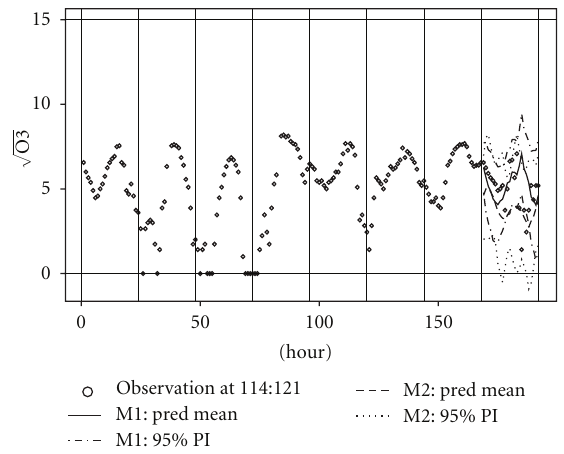
Figure 3: The observed square-root of ozone concentrations (cid:20) ( ppb) from Day 114 to Day 121, the predicted values using M1 and M2, and the 95% pointwise predictive intervals using M1 and M2 at GS 5.